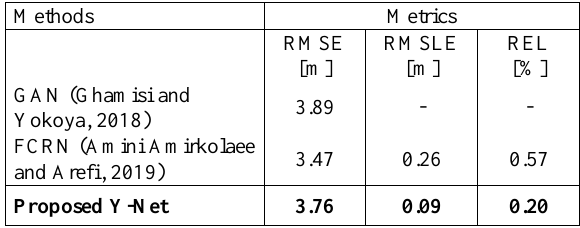
Table 2. Comparison between the proposed Y-Net and the state- of-the-art methods for nDSM prediction over Potsdam dataset As shown in Figure 8, not only the linear elements of roofs are extracted appropriately, but the buildings are also classified and distinguished from non-building objects such as trees and roads.